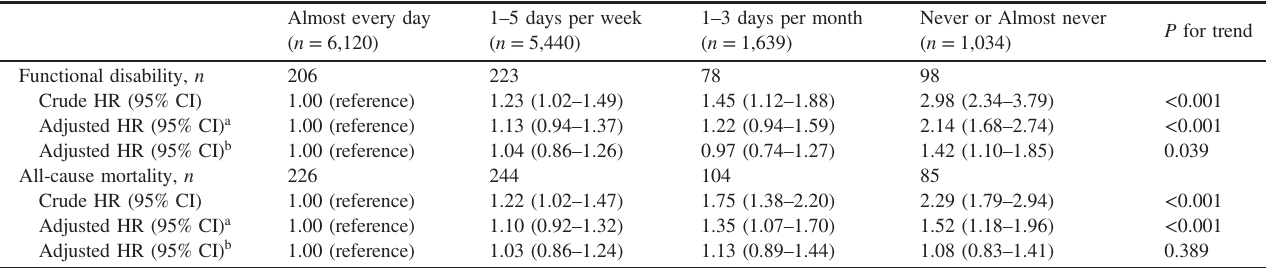
Table 2. Likelihood of onset of functional disability and all-cause mortality according to the frequency of laughter Almost every day ( n =